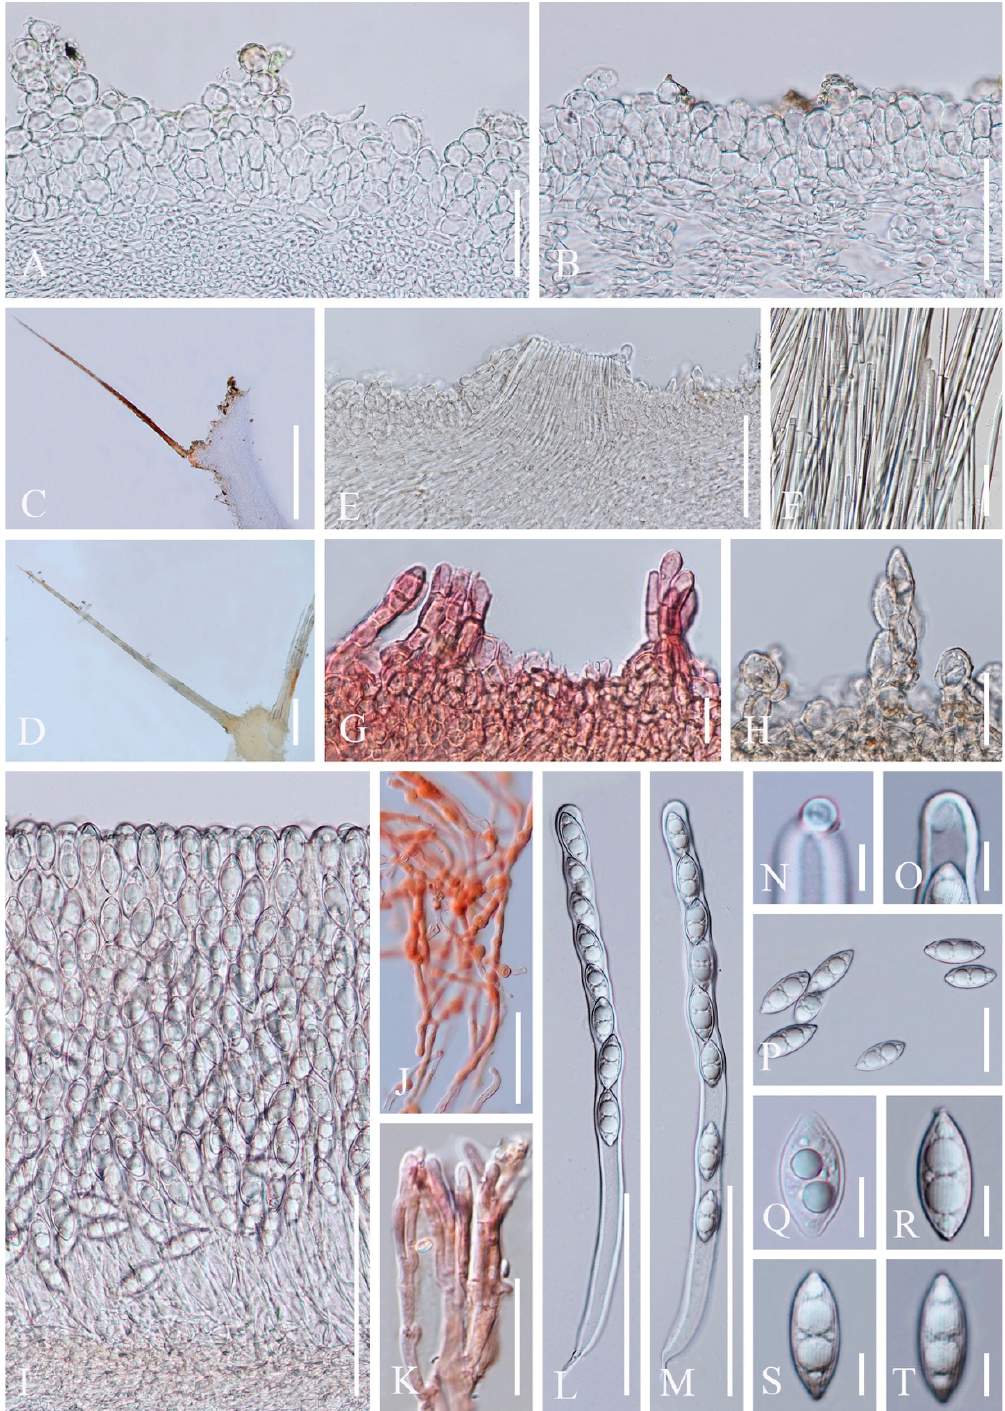
Figure 12. Cookeina tricholoma . ( A ) Vertical section of stipe ectal excipulum. ( B ) Vertical section of receptacle ectal excipulum. ( C , D ) Compound hairs. ( E ) Broken compound hair from medullary excipulum. ( F ) Loose compound hair. ( G ) Hyphoid hairs in CR. ( H ) Monilioid processes. ( I ) Hymenium. ( J ) Paraphyses in CR. ( K ) Apices of paraphyses in CR. ( L , M ) Asci and ascospores. ( N , O ) Apices of the asci. ( P ) Ascospores. ( Q ) Ascospore when young. ( R – T ) Ascospores ornamented by fine longitudinal striate ridges when mature. Scale bars ( A , B , F ) = 50 μ m; ( C , D ) = 500 μ m; ( E , I , L , M ) = 100 μ m; ( G , H , J , K ) = 20 μ m; ( N , O , P , Q – T ) = 10 μ m.